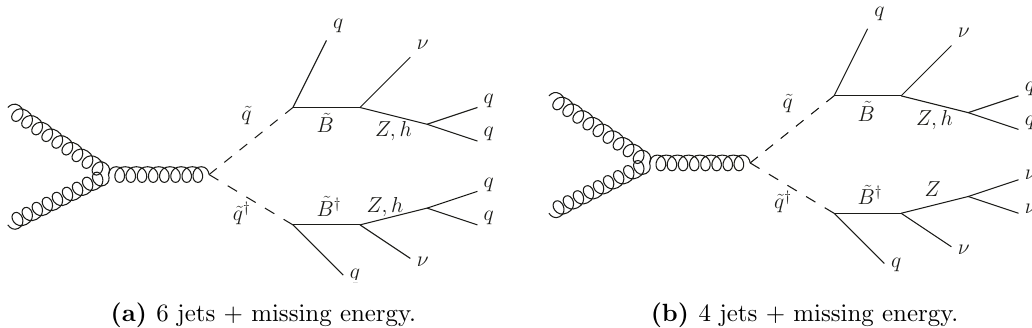
Figure 2. Final states with jets and missing energy. We recast current SUSY searches at ATLAS and CMS for this signal.